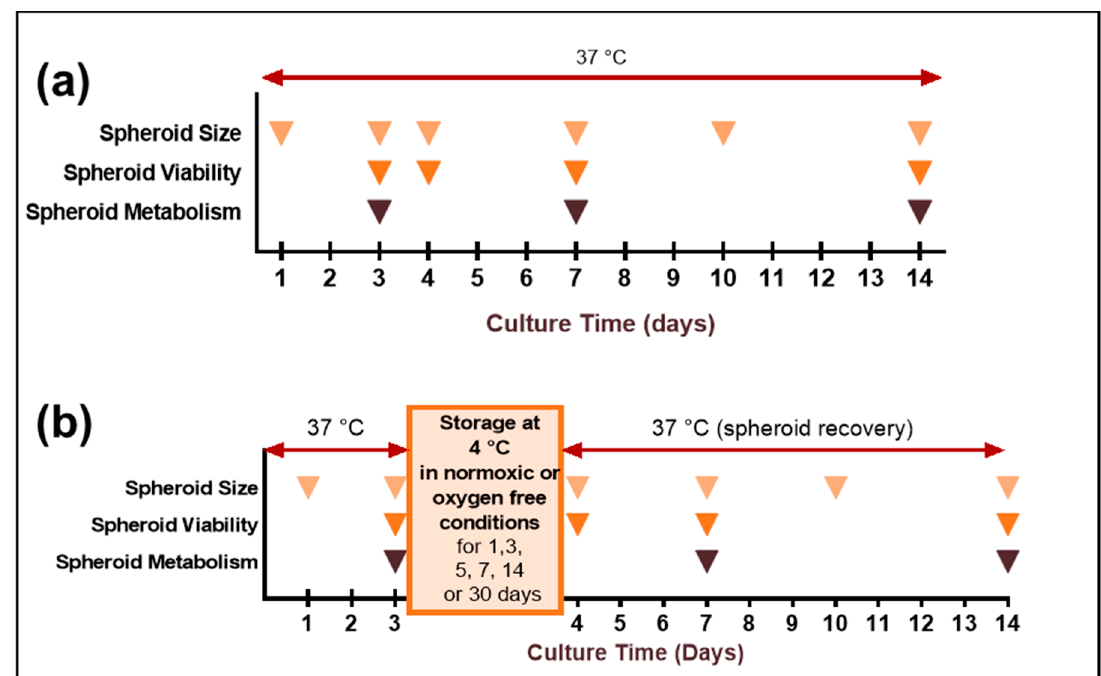
Figure 1. Schematic representation of MDA-MB-231 spheroids cold storage experiments. MDA-MB-231 spheroids were cultured in RPMI 1640 fetal calf serum-supplemented or OptiPASS ® medium and maintained in classic cell culture conditions (humid incubator, 37 °C, 5% CO 2 ). ( a ) For nonstored control condition, spheroids were continuously maintained at 37 °C, i.e., in classic culture conditions, for 14 days. ( b ) For storage experiments, after 3 days of culture, the spheroids in microplates were stored at 4 °C in normoxic or oxygen-free conditions for 1, 3, 5, 7, 14 or 30 days. After storage, spheroids in microplates were replaced in classic culture conditions for 10 supplemental days—i.e., between the 4th and the 14th days of culture.